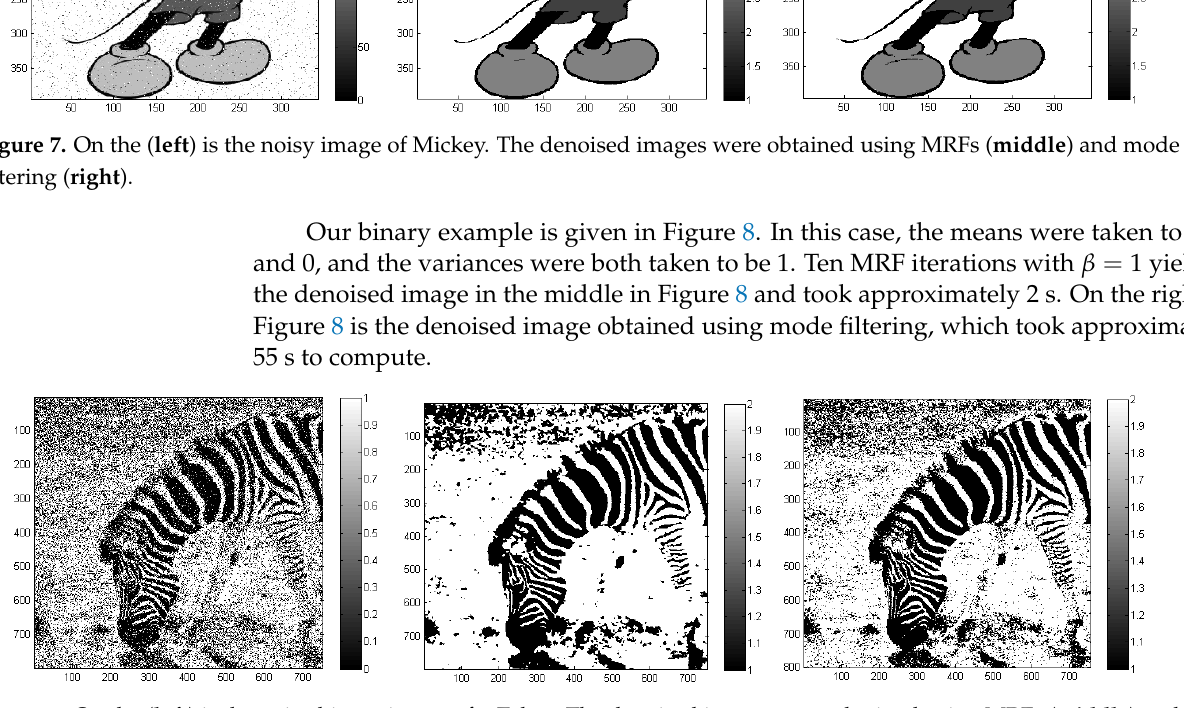
Figure 8. On the ( left ) is the noisy binary image of a Zebra. The denoised images were obtained using MRFs ( middle ) and mode filtering ( right